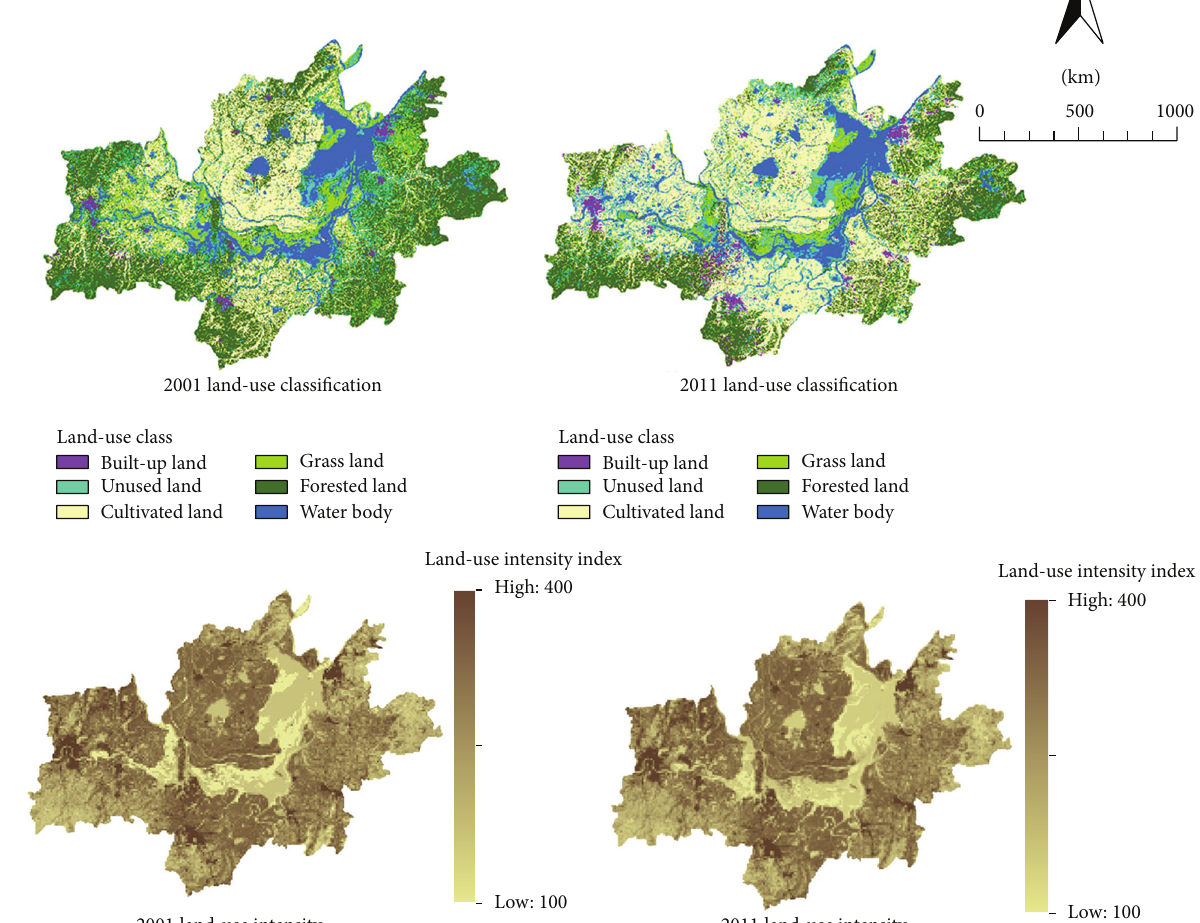
Figure 3: Spatial expression of the land-use classification and land-use intensity in 2001 and 2011.